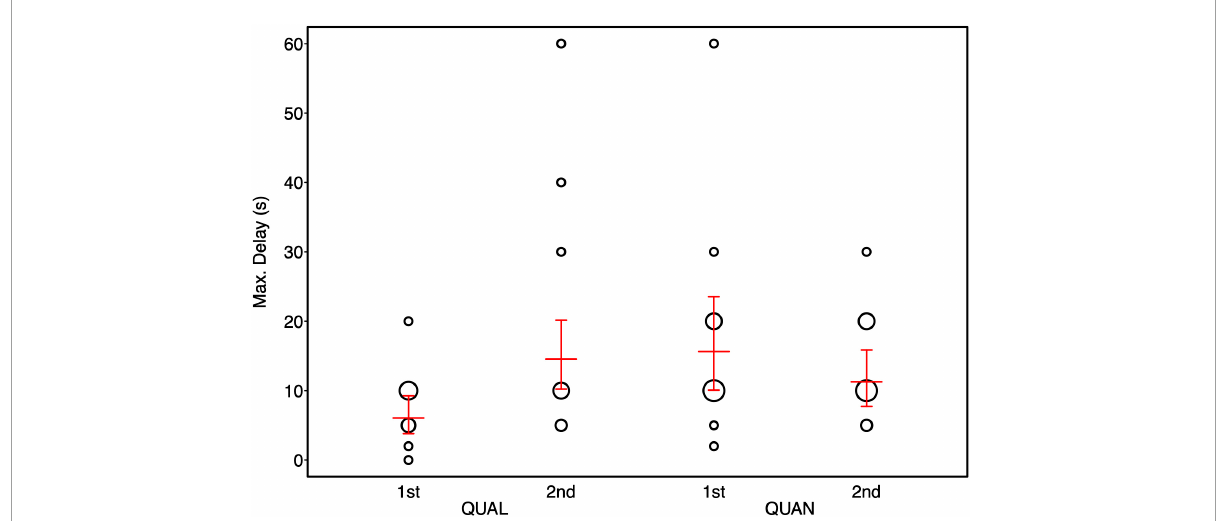
FIGURE4 Maximum delay stages reached by horses in the quality (QUAL) and quantity (QUAN) test condition as a function of test order. Bubbles depict the frequency of maximally tolerated delay stages while the area of the bubbles corresponds to the number of horses (range: 1–7). The red horizontal bar depicts the fitted model and the error bars show the confidence limits for feeding management centered to a mean of zero.